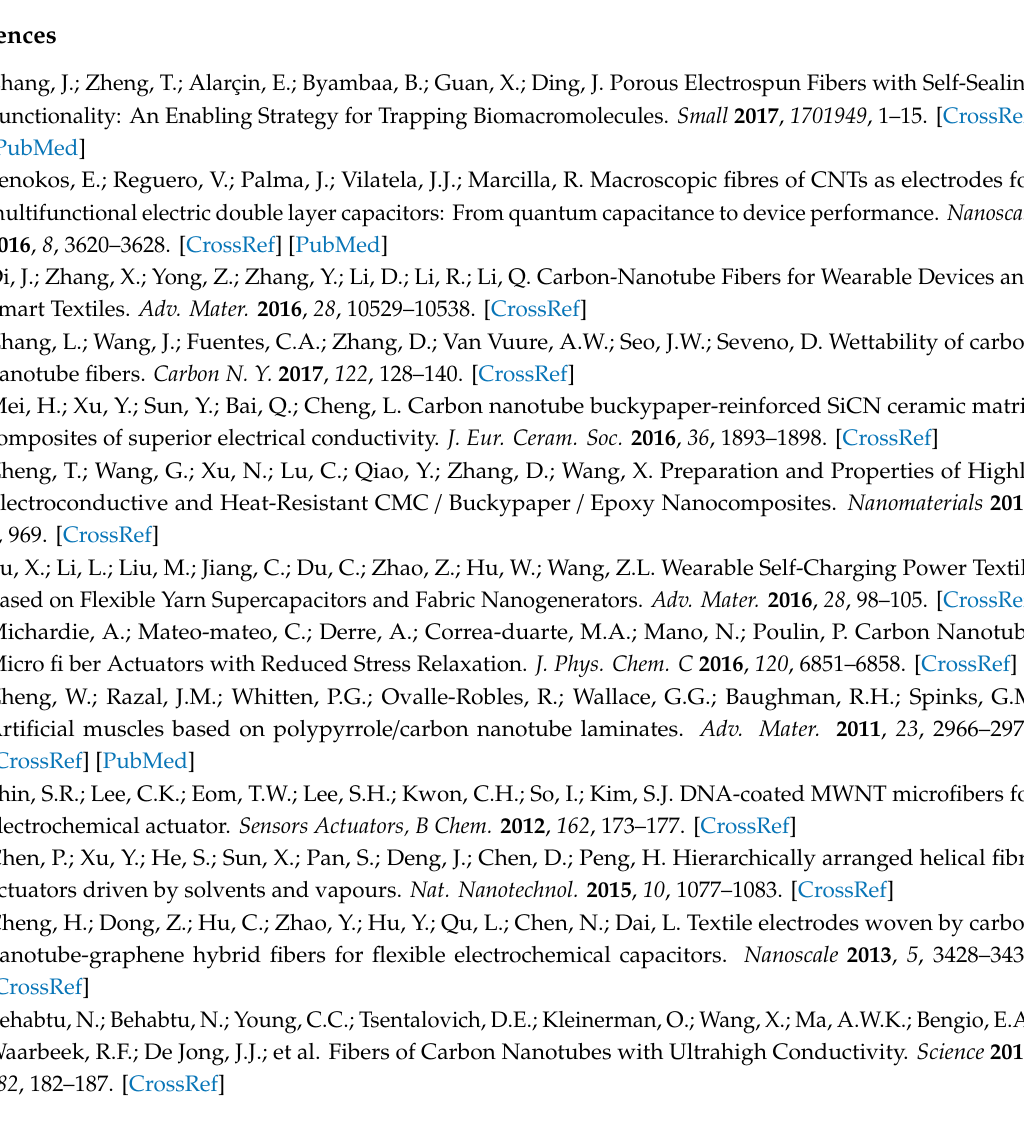
Figure S1: The graphs of HA / MWCNTs microfibers prepared with di ff erent injection speed, Figure S2: DTG curves of HA and HA / MWCNTs